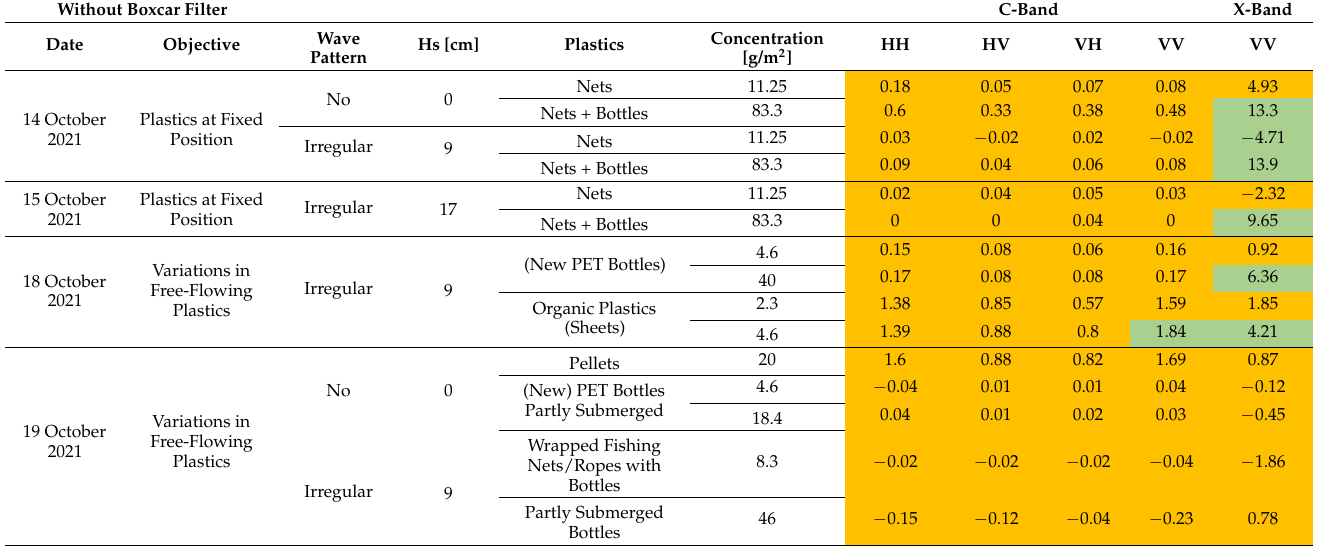
Table 4. Results of statistical analysis undertaken on 1st campaign measurements without the use of a boxcar filter. Values filling the table are the results of the difference of the reference measurement and test measurement in a linear format. Any value in green shows that the alternative hypothesis was fulfilled; any value in orange shows that the null hypothesis was